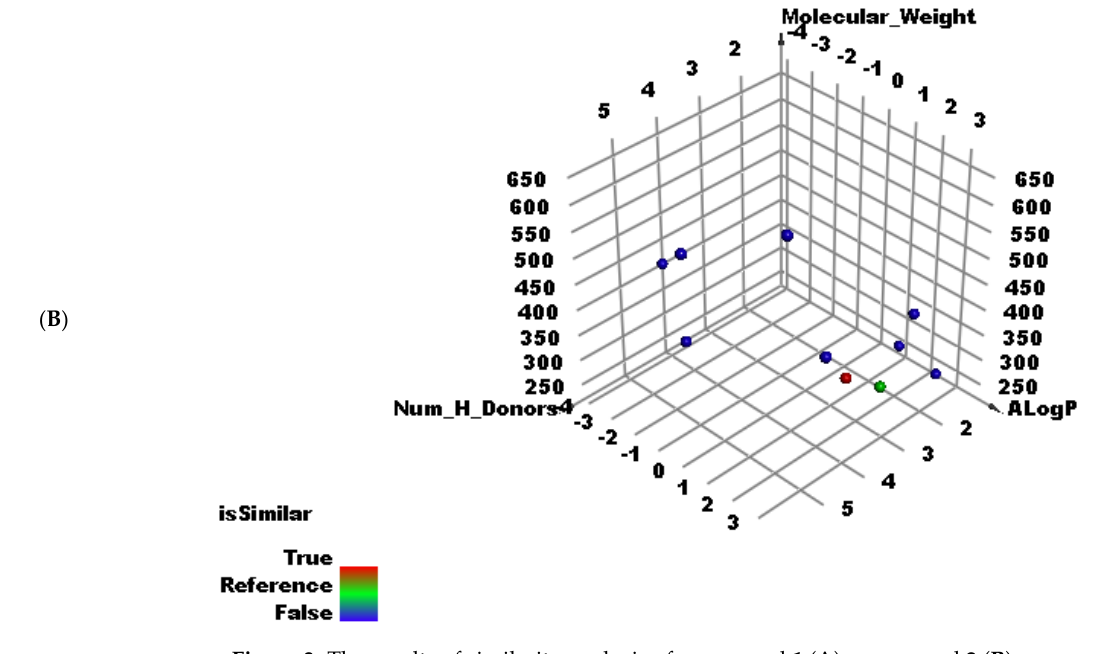
Figure 3. The results of similarity analysis of compound 1 ( A ), compound 2 ( B ).